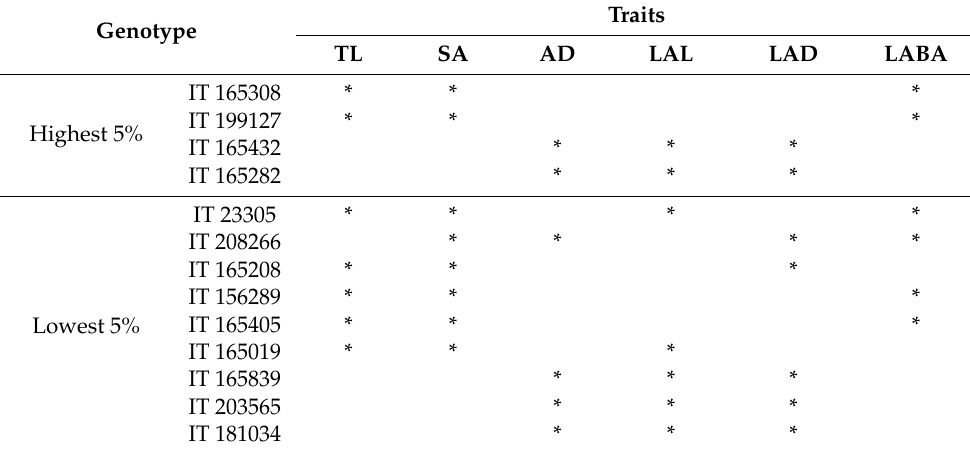
Table 2. Information on soybean genotypes included in the 5% highest and lowest groups that occurred more than three times among the six morphological traits. The star mark in the table means that the genotype was included in 5% of each side. In the table, each abbreviation indicated total length (TL), average diameter (AD), surface area (SA), link average length (LAL), link average diameter (LAD), and link average branching angle (LABA),